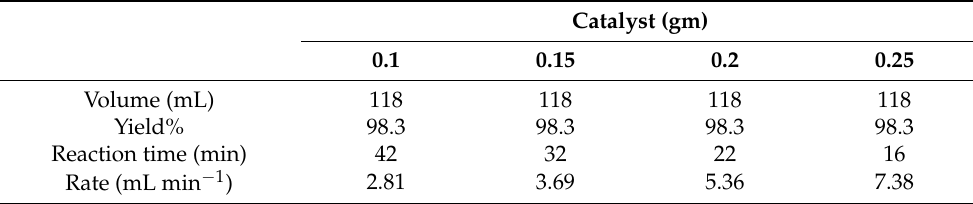
Figure 8. Effect of SBH concentration on H 2 generation ( A ) and the value of H 2 generation vs. value of [SBH] on logarithmic scale ( B ). The amount of Ni 75 Pd 25 @PVDF-HFP NFs membrane catalyst = 100 mg and T = 298 K. To examine the effect of temperature on the reaction, 1 mmol of SBH was hydrolyzed employing 100 mg of Ni 75 Pd 25 @PVDF-HFP membranes while the temperature was varied from 298 K to 328 K. The plot of time versus volume of H 2 produced during SBH hydrolysis at various temperatures is depicted in Figure 9A. Increasing the reaction